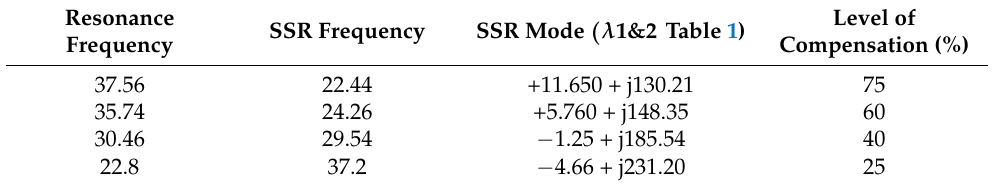
Table 4. SSR mode and eigenvalues for compensation levels with wind speed 7